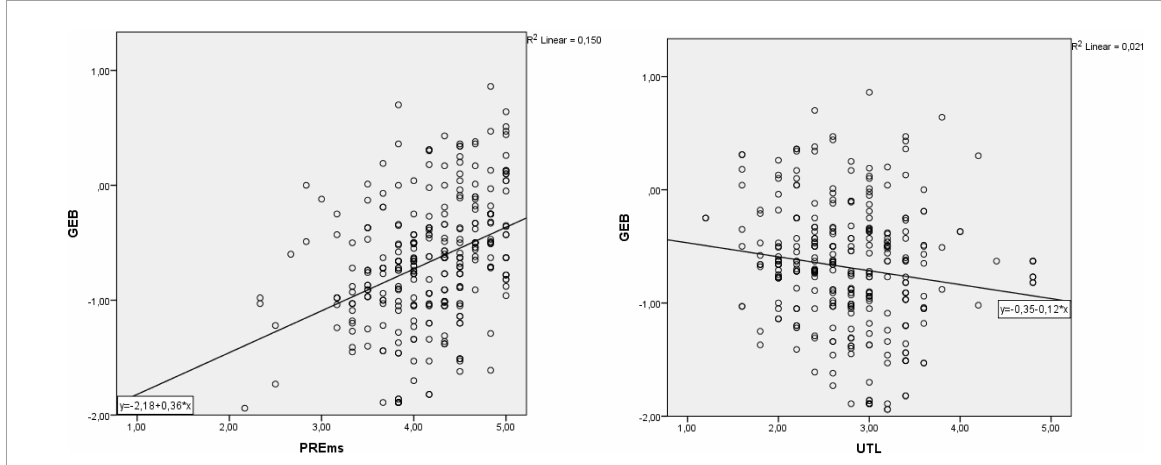
FIGURE2 Correlation pattern of preservation vs behaviour and utilisation vs behaviour.